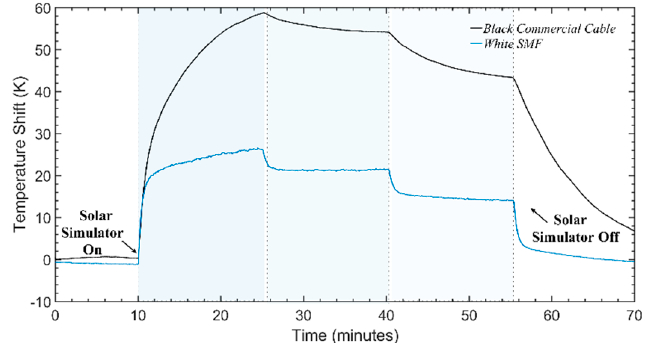
Figure 7. Temperature behavior obtained the white fiber ( blue trace ) and with a commercial black cable ( black trace ), under ~15-min solar irradiance cycles of 0 W / m 2 , 1000 W / m 2 , 750 W / m 2 500 W / m 2 , and 0 W / m 2 , at room temperature.